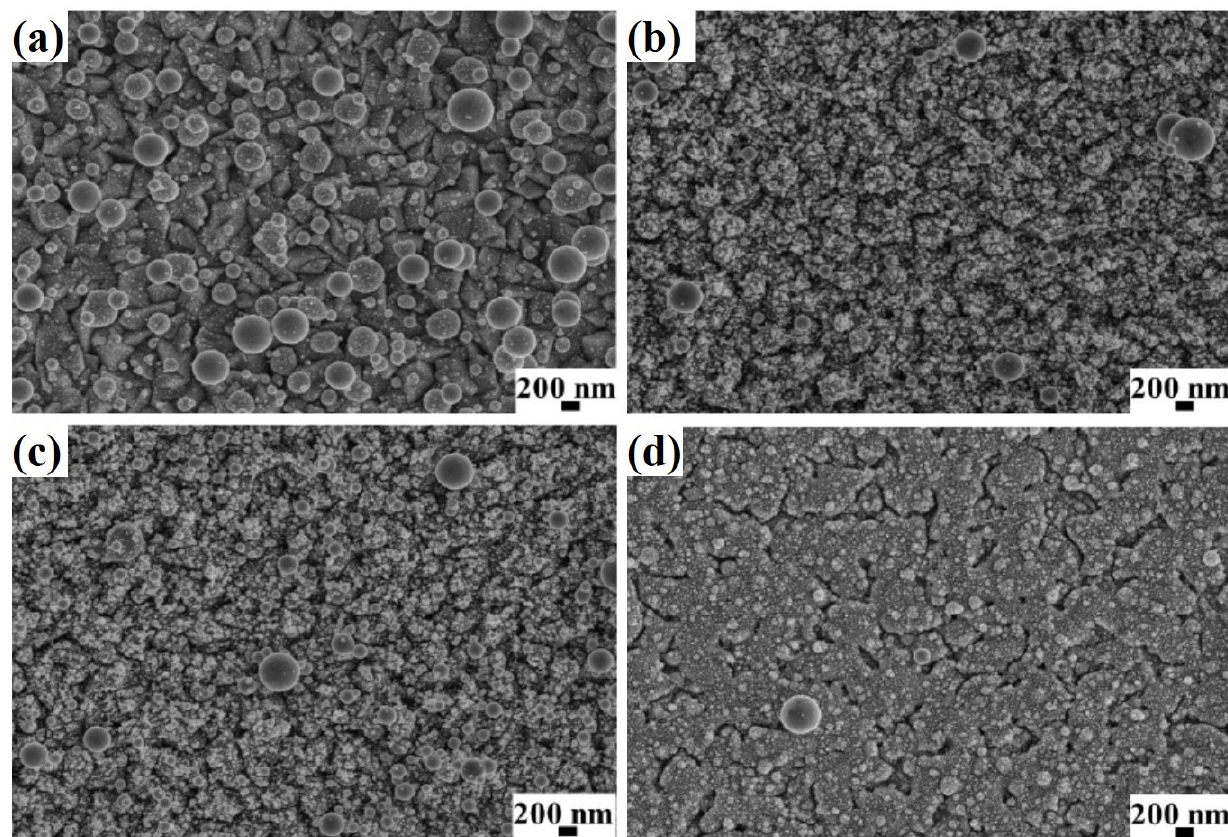
Figure 3. SEM images of FTO surface covered by 48.6-nm-thick Au-Pd film and laser irradiated at the fluence values ( a ) 0.50 J/cm 2 , ( b ) 0.75 J/cm 2 , ( c ) 1.00 J/cm 2 and ( d ) 1.50 J/cm 2 .